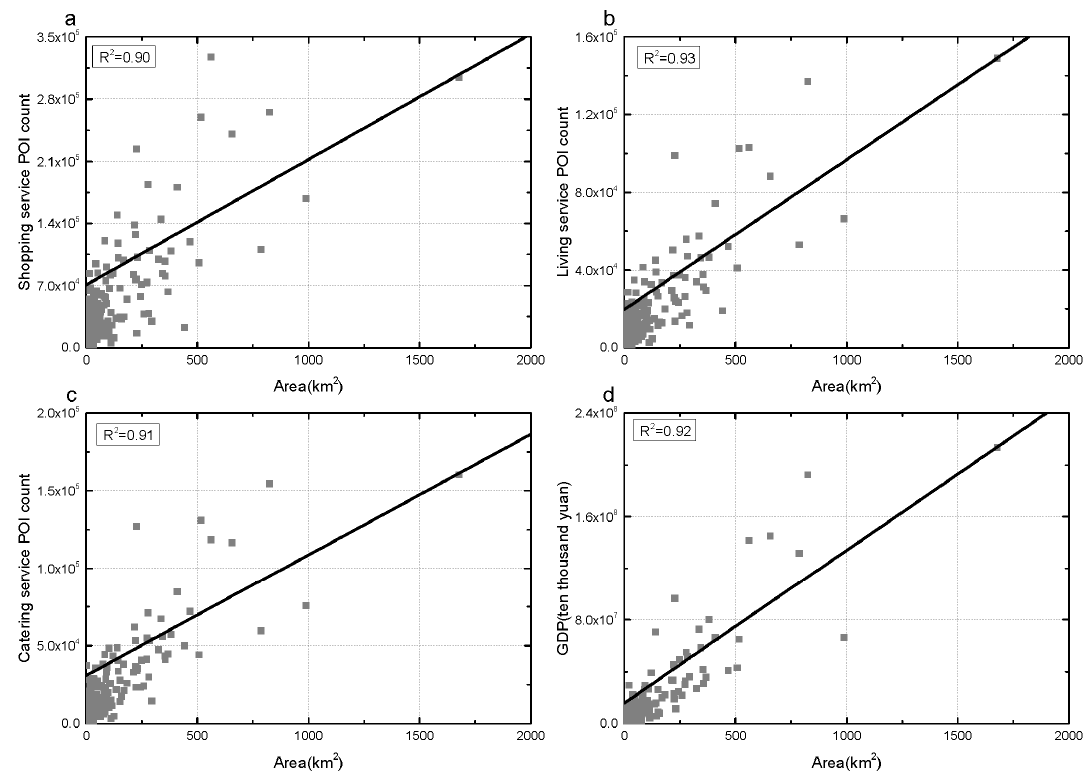
Figure 9. Statistical relationships between urban areas and social interactions and production. ( a ) The relationship between urban areas and shopping service POI count; ( b ) The relationship between urban areas and living service POI count; ( c ) The relationship between urban areas and catering service POI count; ( d ) The relationship between urban areas and GDP.